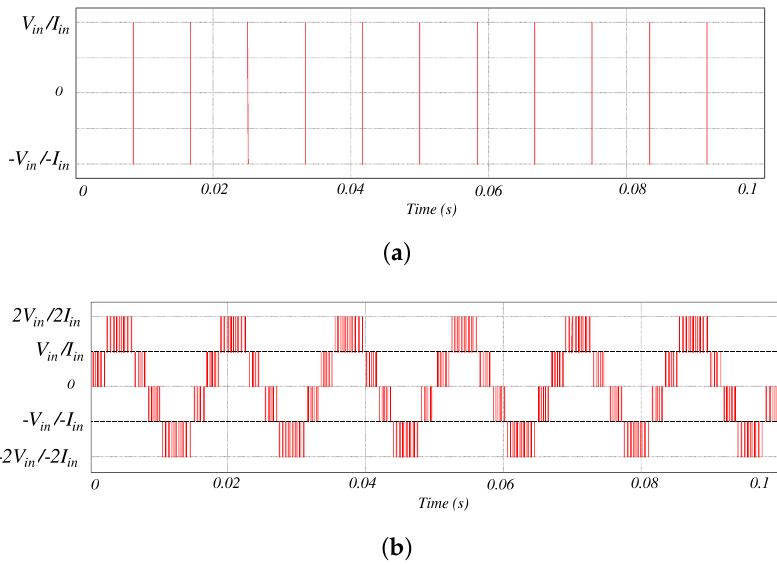
Figure 3. Output comparison: ( a ) Traditional inverters, ( b ) Multilevel